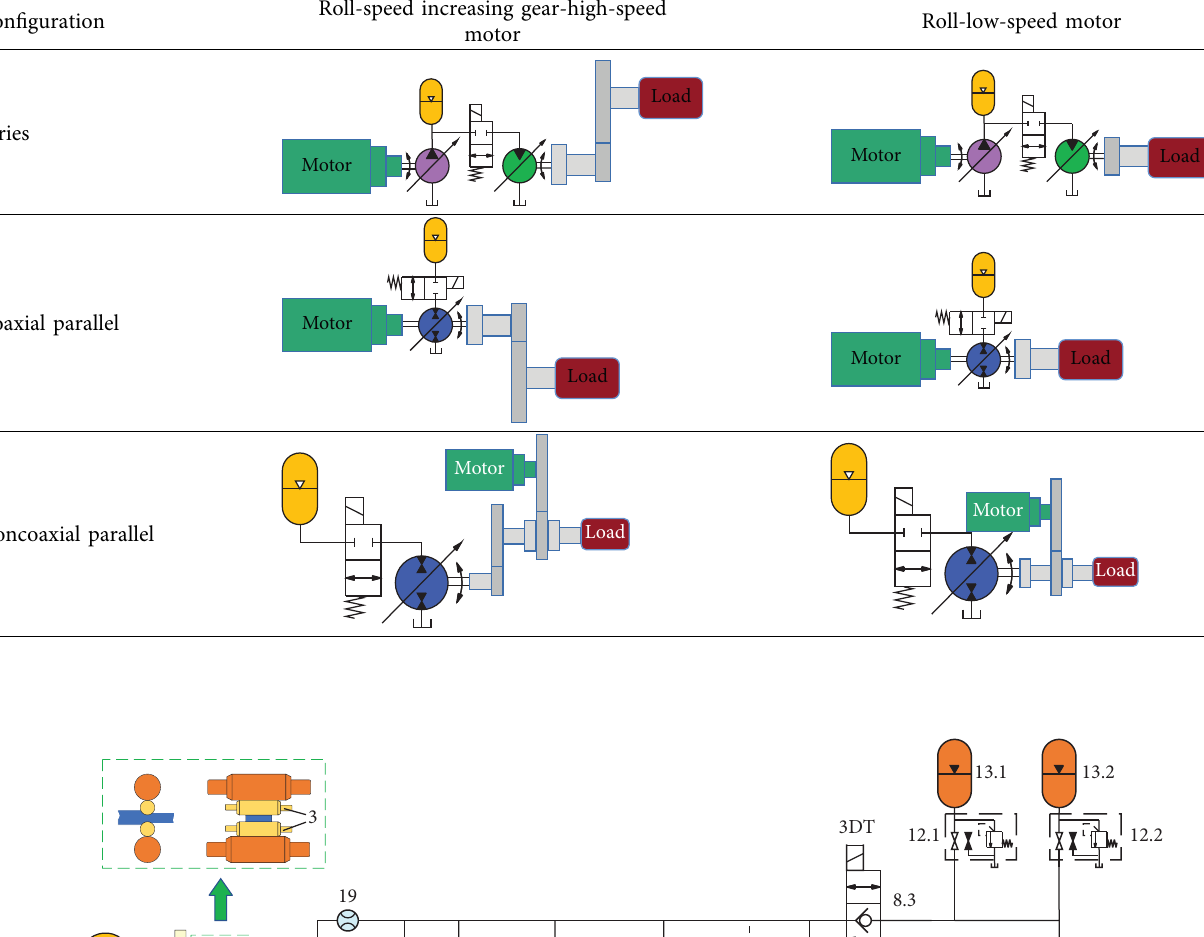
Table 3: Confguration of energy recovery system based on the reversible rolling mills.